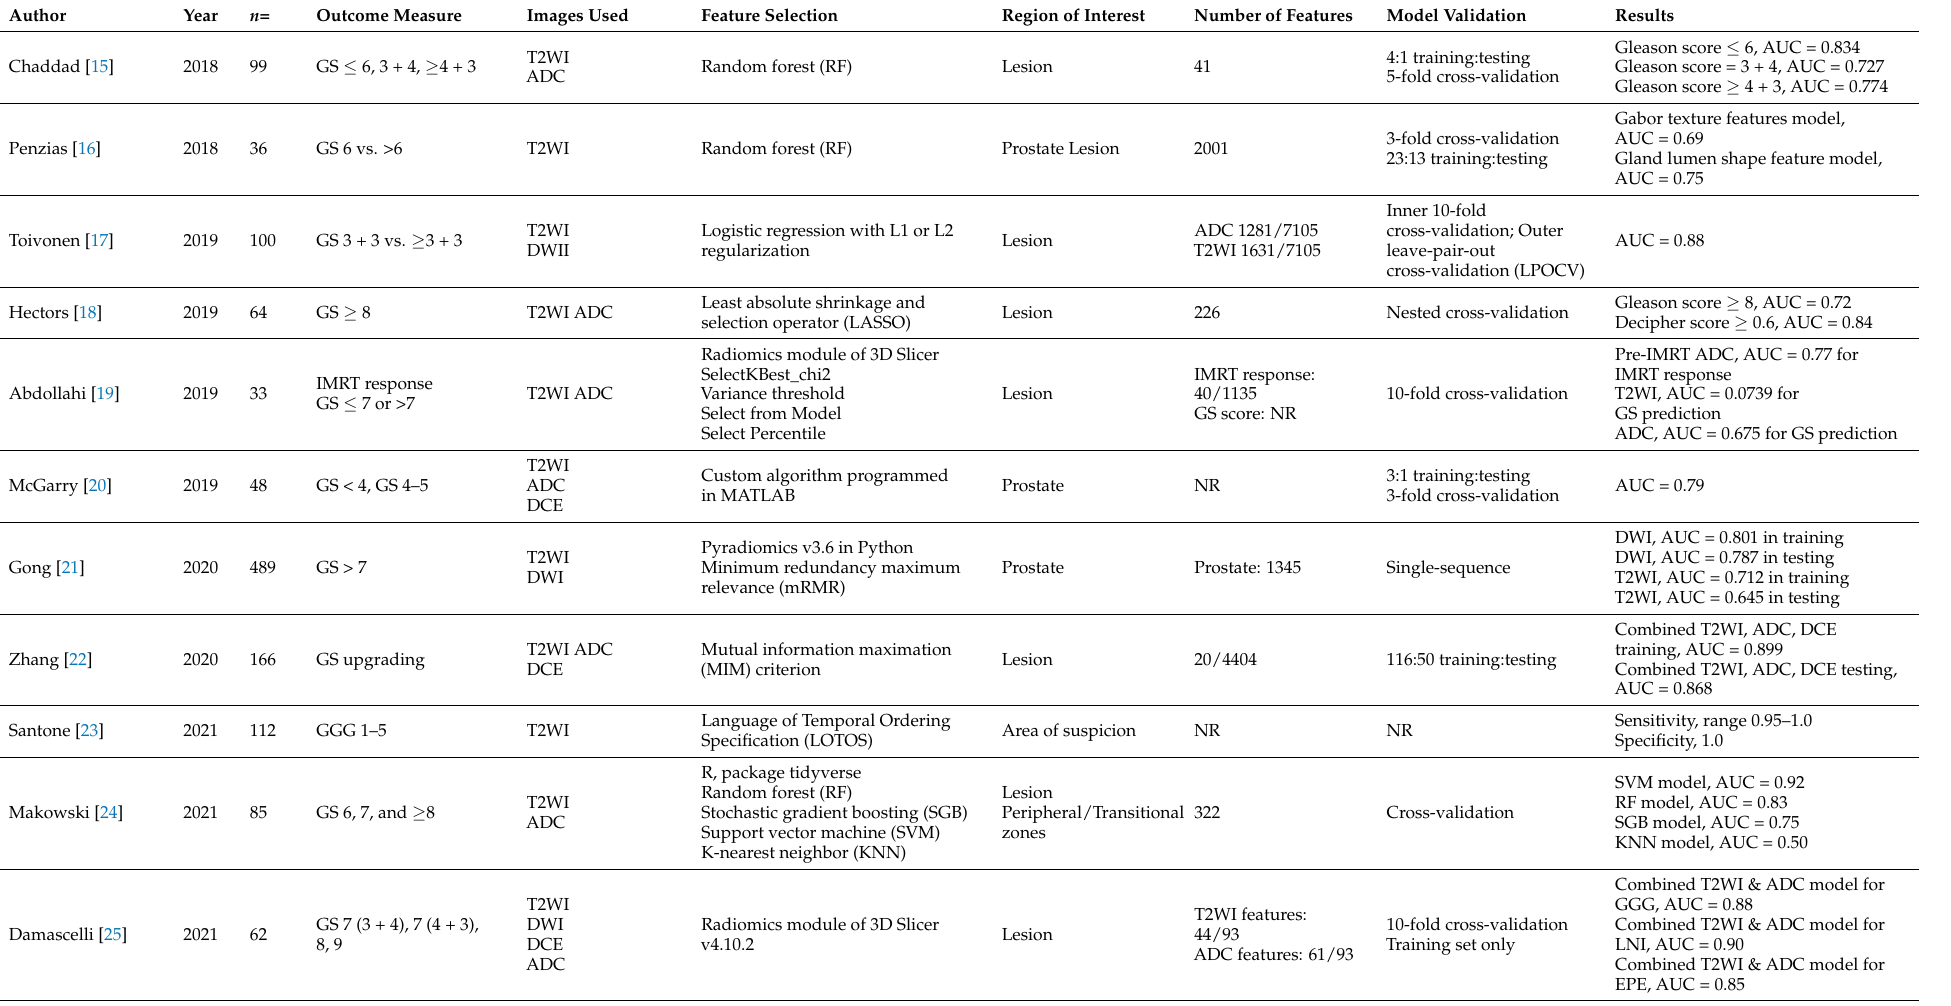
Table 1. Summary of studies utilizing magnetic resonance imaging (MRI)-derived radiomic models to predict Gleason